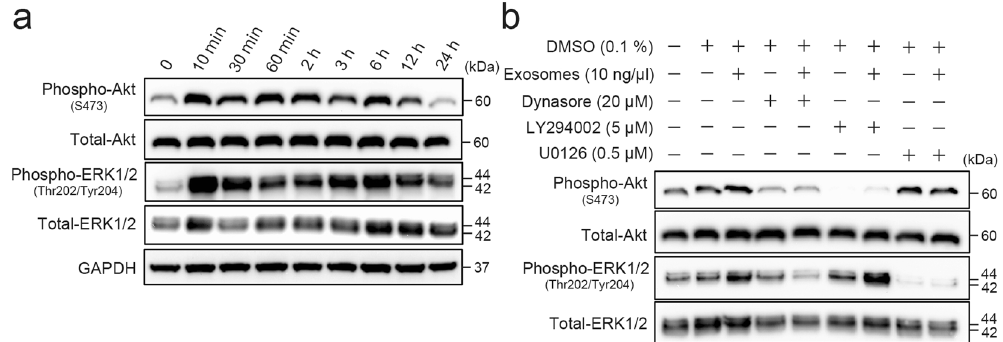
Figure 4. Activations of PI3K/Akt and MAP kinase signalling in HUVECs treated with exosomes released from PK-45H cells. ( a ) Phosphorylation status of Akt and ERK1/2 in treated HUVECs. Phosphorylated proteins were detected by Western blotting. Treatment of exosomes enhanced phosphorylation of Akt and ERK1/2 in HUVECs. Full-length blots are present in Supplementary Fig. S4. ( b ) Effects on activation of Akt and ERK1/2 in treated HUVECs in the presence or absence of dynasore, PI3 kinase inhibitor (LY294002) and MEK inhibitor (U0126). Phosphorylation of Akt and ERK1/2 was induced by dynamin-dependent exosomal endocytosis. Full- length blots are present in Supplementary Fig.